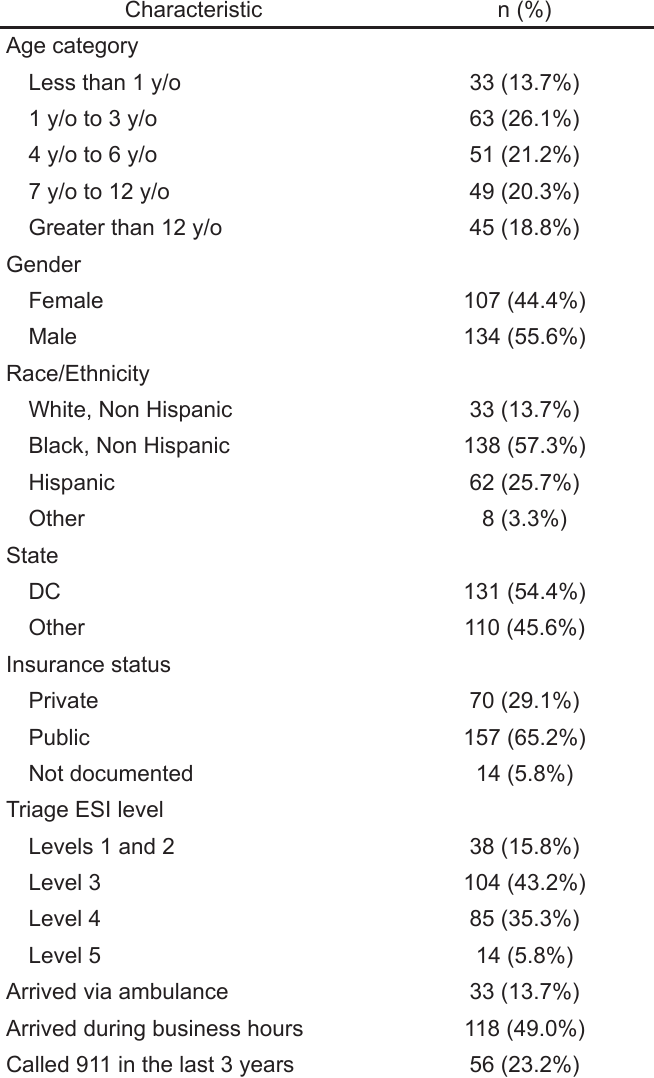
Table 1. Selected population characteristics for children of the enrolled caregivers (N =